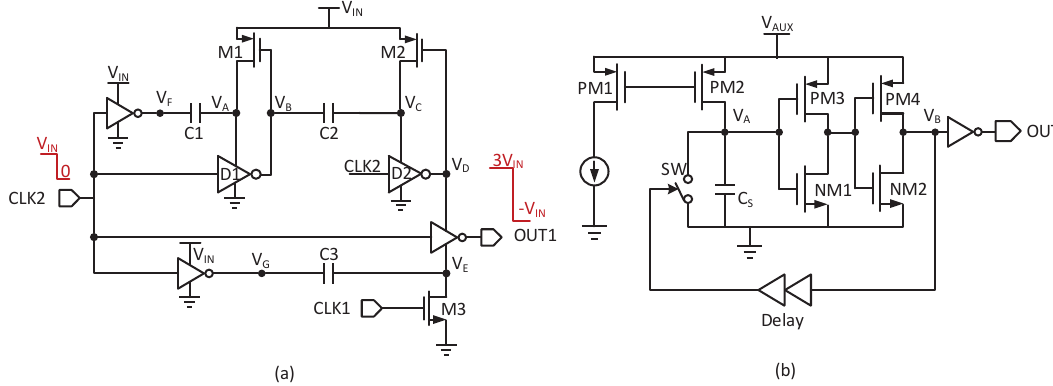
Figure 7. ( a ) The clock booster; ( b ) the large duty cycle